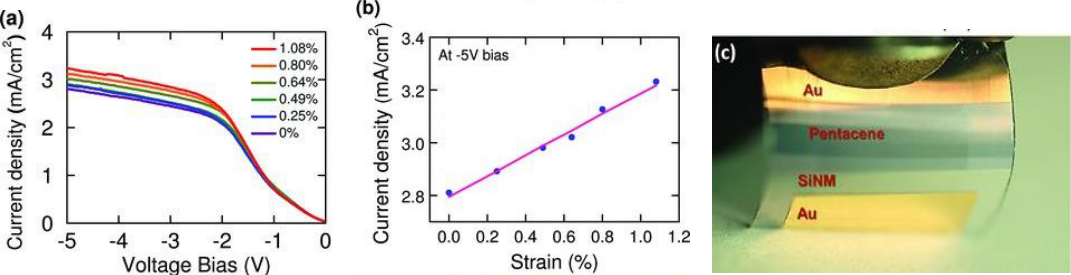
Figure 19. Characterizations Si NM-pentacene diode under mechanical bending. ( a ) Measured photocurrent of the diode under different bending strains. ( b ) Plot of photocurrent change as a function of strain. ( c ) An optical image of the diode under bending (reprinted from [42]).